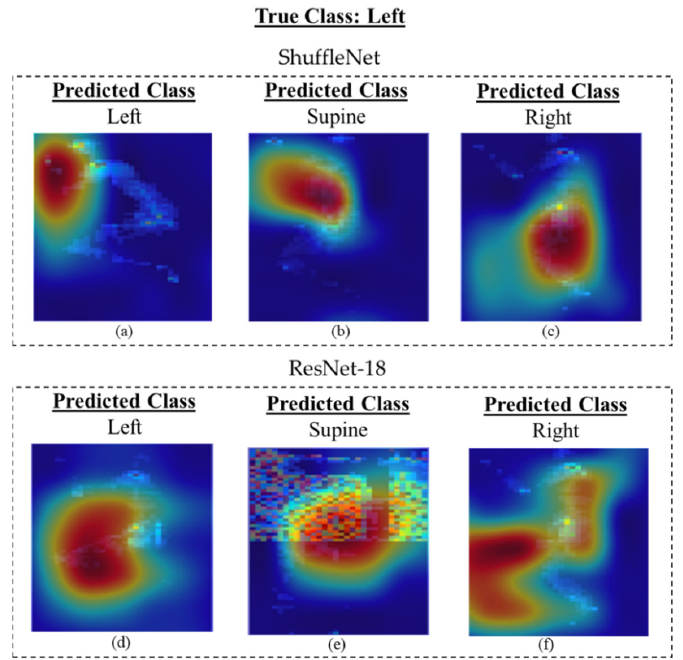
Figure 6. Grad-CAM images of the ShuffleNet and ResNet-18 models predicting left side posture: ( a ) correct prediction, ( b ) misclassified label as supine, and ( c ) misclassified label as right side with ShuffleNet. ( d ) Correct prediction, ( e ) misclassified label as supine, and ( f ) misclassified label as right side with ResNet ‐ 18.